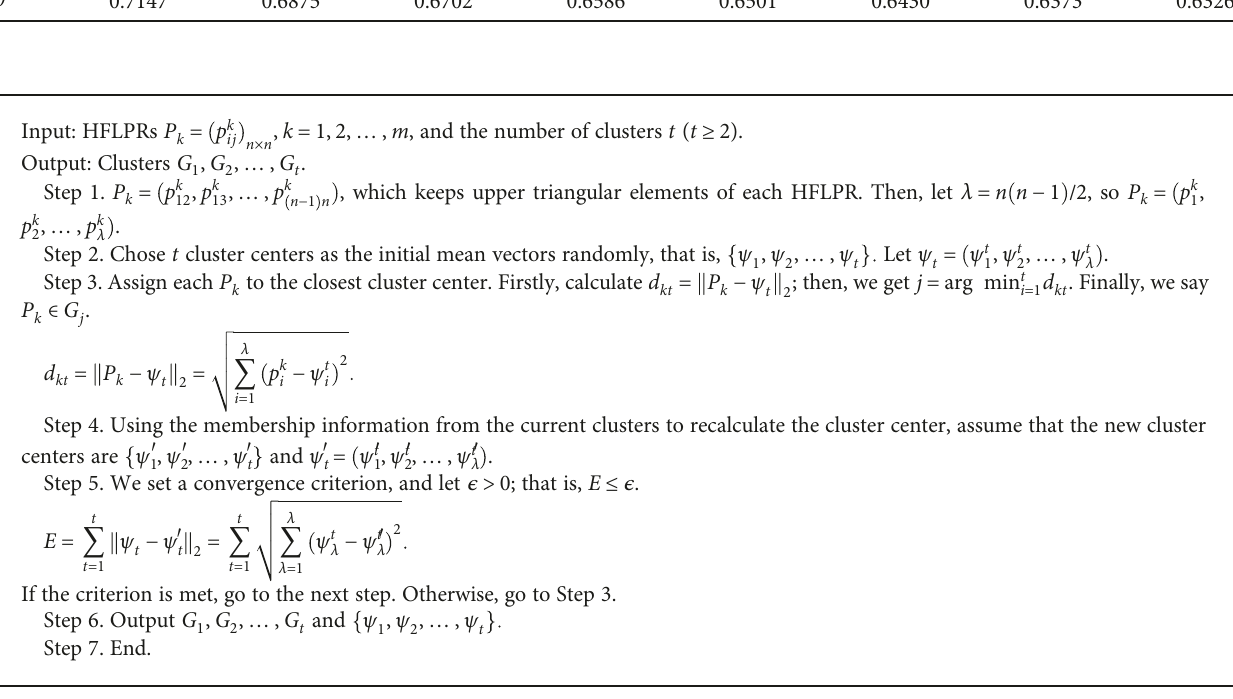
e ff ect of di ff erent aggregation functions on both the consis- tency and consensus calculation process.